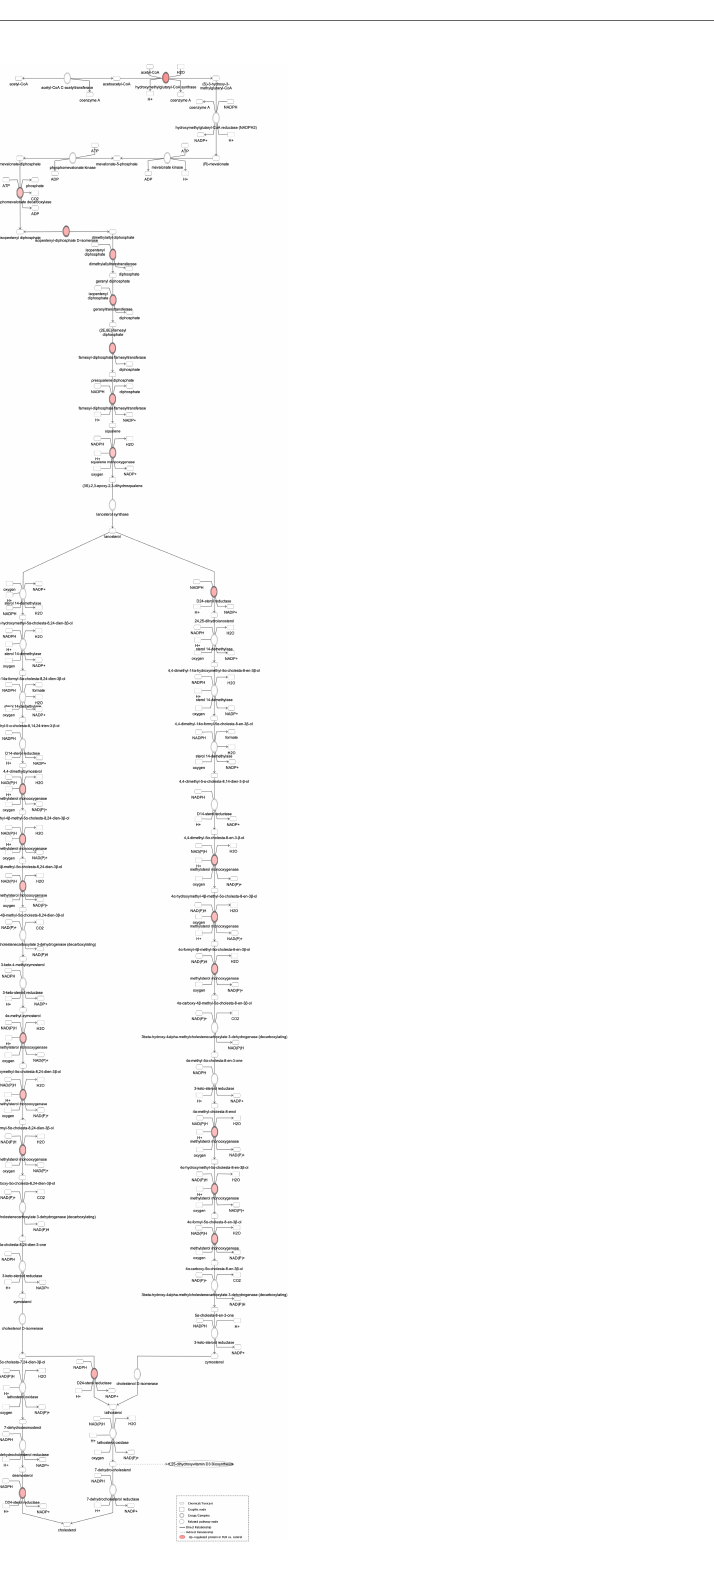
FIGURE 4 | Ingenuity Pathway Analysis of DEPs between FGR vs. Control group. Induction of the super pathway of cholesterol biosynthesis . (z = 2.2, p = 1.5e-4) .